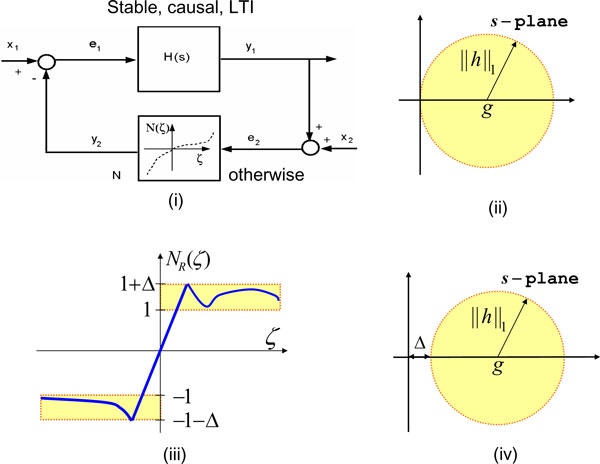
Stability analysis of feedback systems. (i) We decompose any given system as a feedback interconnection of a linear time-invariant system H and an otherwise system N. Stability of the feedback interconnection follows if there exists a hyperplane that separates the graph of H from the inverse graph of N. If N is a monotone nonlinearity, the Zames-Falb multipliers are commonly used to reduce conservatism in multiplier-based stability analysis of this system. (ii) The Nyquist plot of a Zames-Falb multiplier is constrained to lie inside an open disc in the right-half s-plane. (iii) Rantzer has investigated these distortions of monotone nonlinearities, and has shown that the stability multipliers for such systems can be obtained by adding a DC offset to the Zames-Falb multipliers (see [15]). The Nyquist plot of these multipliers is constrained to lie in the open disc shown in (iv).